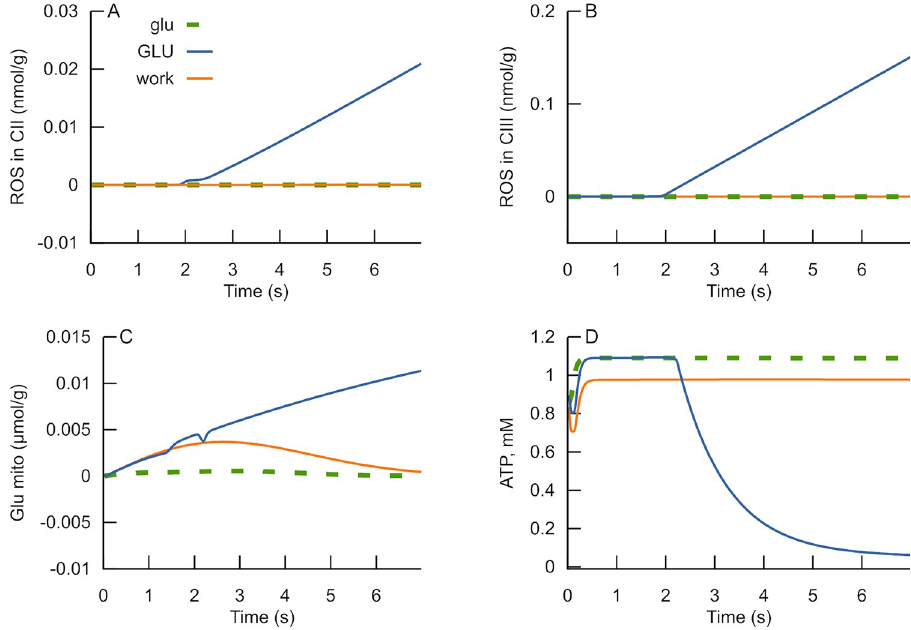
Fig 7. Cellular ATP levels and ROS production at various glutamate concentrations and workload (ATPase). Dynamics of ROS production rate in complex II (A), complex III (B), mitochondrial glutamate (C), and cellular ATP levels (D) at various rates of glutamate uptake and cellular ATPase activity. Dashed green curves in panels A-D, labeled as “glu,” represent simulations of conditions when excitation results in uptake of 1 μ mol of glutamate per 1 g of tissue and ATPase rate of 1nmol × g -1 × s -1 . Blue curves in panels A-D marked as “GLU” represent simulations of conditions when excitation results in glutamate uptake of 3 μ mol/g of tissue and the sameATPase rate. Orange curves labeled as “work” represent simulations of conditions when excitation results in glutamate uptake of 3 μ mol/g of tissue and ATPase rate of 10nmol × g -1 × s -1 . The code, initial values and rate constants corresponding to this simulation are available in https://github.com/seliv55/cell_mito/tree/fig8.